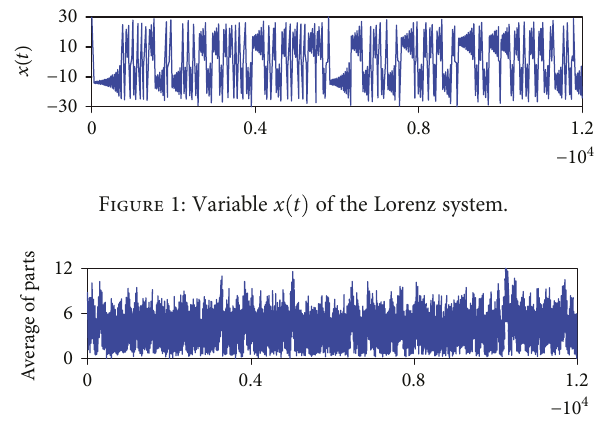
Figure 2: Average of parts in the waiting line.